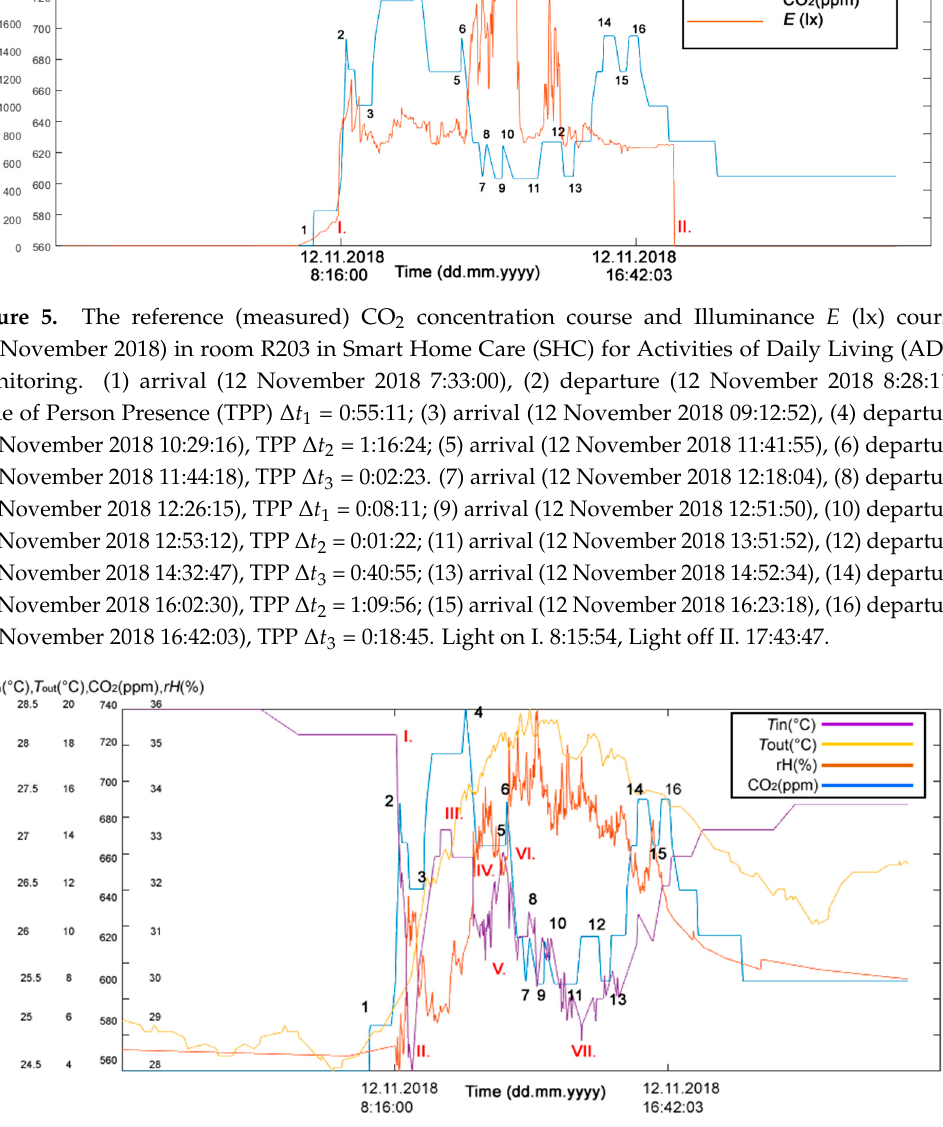
9 of 27 The Correlation coefficient ( R ) measures a level of the linear dependency between two signals. The more the signals are considered linearly dependable, the higher the correlation coefficient is. In comparison with the previous parameters, the correlation coefficient represents a normative parameter. Zero correlation stands for the total dissimilarity between two signals, measured in a sense of their linear dependency. Contrarily, 1 and − 1 stand for full positive and full negative correlation. As we have already stated above, in our work, we analyze two-month CO 2 predictions. In each measurement, we have a prediction from the neural network with 10, 50, 100, 150, 200, 250, 300, 350 and 400 neurons. Thus, we completely analyzed 9 predicted signals for each measurement. These signals are compared against the reference based on the evaluation parameters stated above. In terms of the Euclidean distance and MSE, lower values indicate a higher agreement between the signal and reference and thus, a better result. Contrarily, a higher correlation coefficient shows better results. In the following part of the analysis, we report the results of the quantification comparison. All the testing is done for the Wavelet Db6, with 6-level decomposition and the Wavelet settings as follows: threshold selection rule—Stein’s Unbiased Risk and soft thresholding for selection of the detailed coefficients. 4. The Practical Experimental Part 4.1. First Part of the ADL Information in SHC from the CO 2 Concentration Course, Blinds, Slats and On/Off Control of Lights The first experimental part in the study addressed the real needs of seniors who live in their own flats despite advanced age and mental and physical disabilities. These people strive to maintain maximum self-sufficiency and, thus, remove as much burden from their relatives, neighbors, friends or surroundings as possible. An example is a married couple, one of whom is mentally impaired, the other being the caregiver. They stay in touch with their family (their children) by SMS to keep them informed about how they are. In situations of acute need, the children are ready to come and help. In this example, the indirect ADL (Activities of Daily Living) in Room R203 (Figure 2) in SHC can be detected by monitoring operational and technical functions, such as